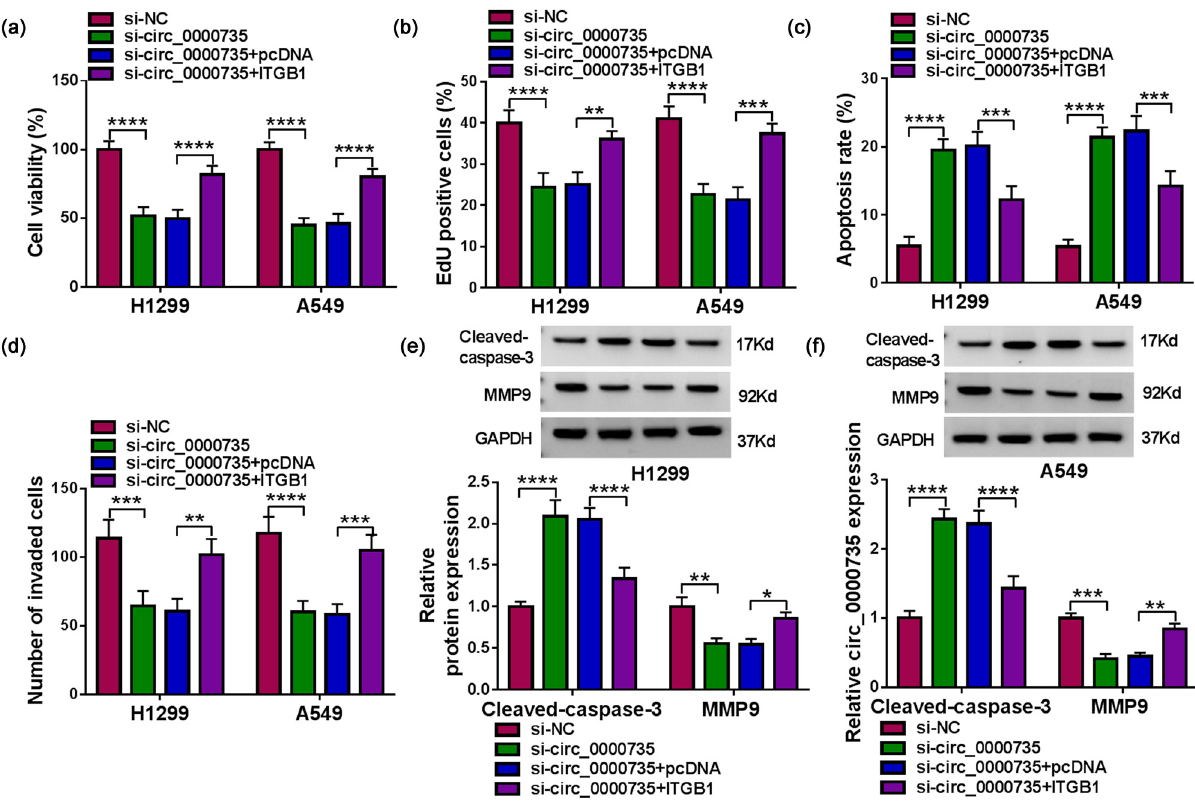
Figure 6: circ_0000735 regulated NSCLC cell proliferation, apoptosis, and invasion via ITGB1. ( a – d ) E ff ects of ITGB1 upregulation on si - circ_0000735 - transfected NSCLC cell viability, proliferation, apoptosis, and invasion were determined using MTT, EdU, fl ow cytometry, and transwell assays ( n = 3 ) . ( e and f ) Western blotting analysis of the e ff ects of ITGB1 overexpression on protein levels of Cleaved - caspase3 and MMP9 in si - circ_0000735 - transfected NSCLC cells ( n = 3 ) . * P < 0.05, ** P < 0.01, *** P < 0.001, and **** P <